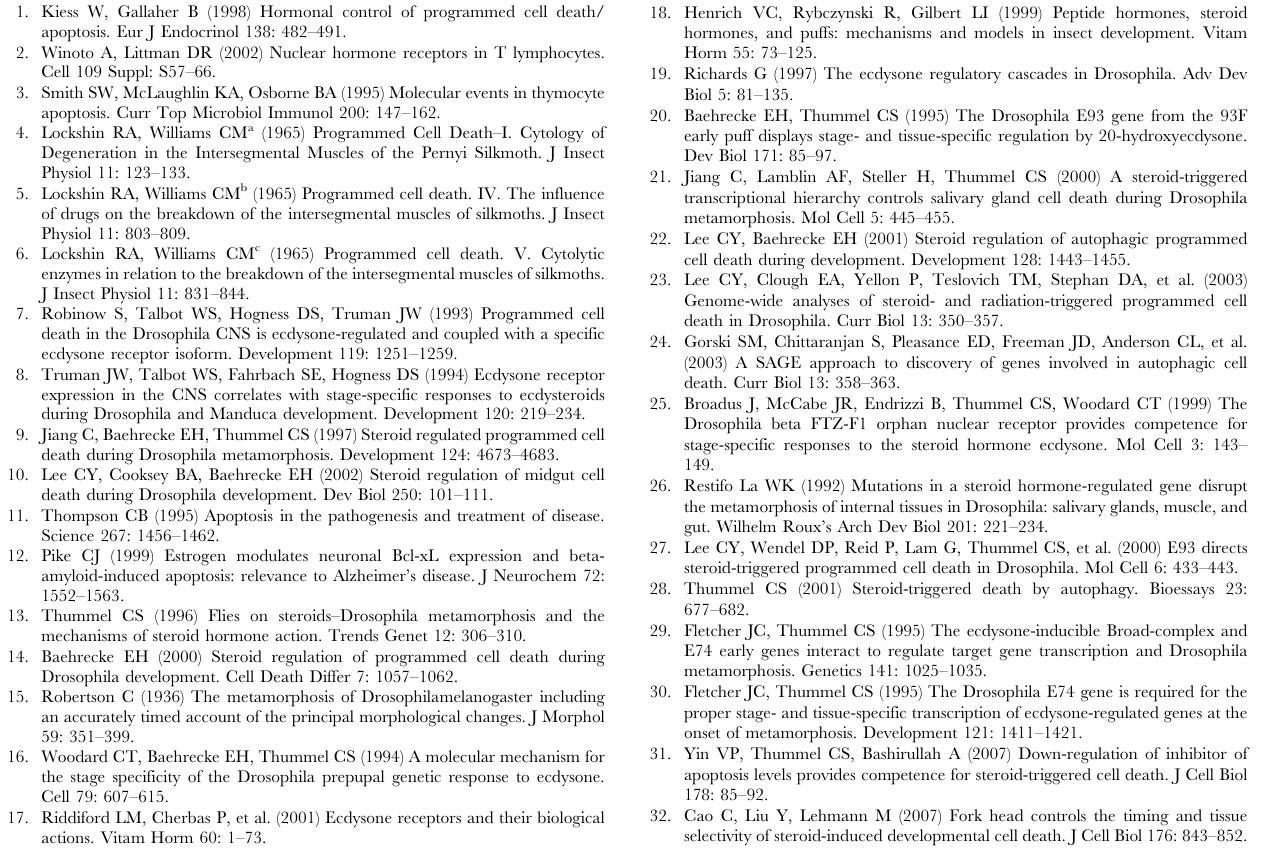
Table S2 Comparison of RNAi effects on cell viability and ecdysone dependency in l(2)mbn and S2 cells.